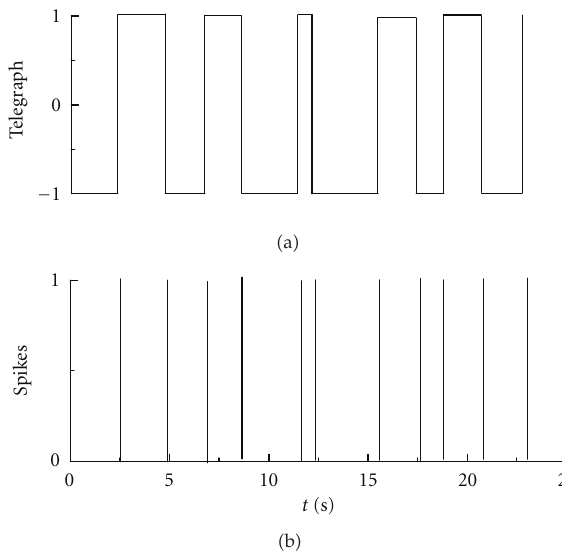
Figure 5: Mapping of a spike train (cid:2) b (cid:3) into a telegraph signal (cid:2) a (cid:3)